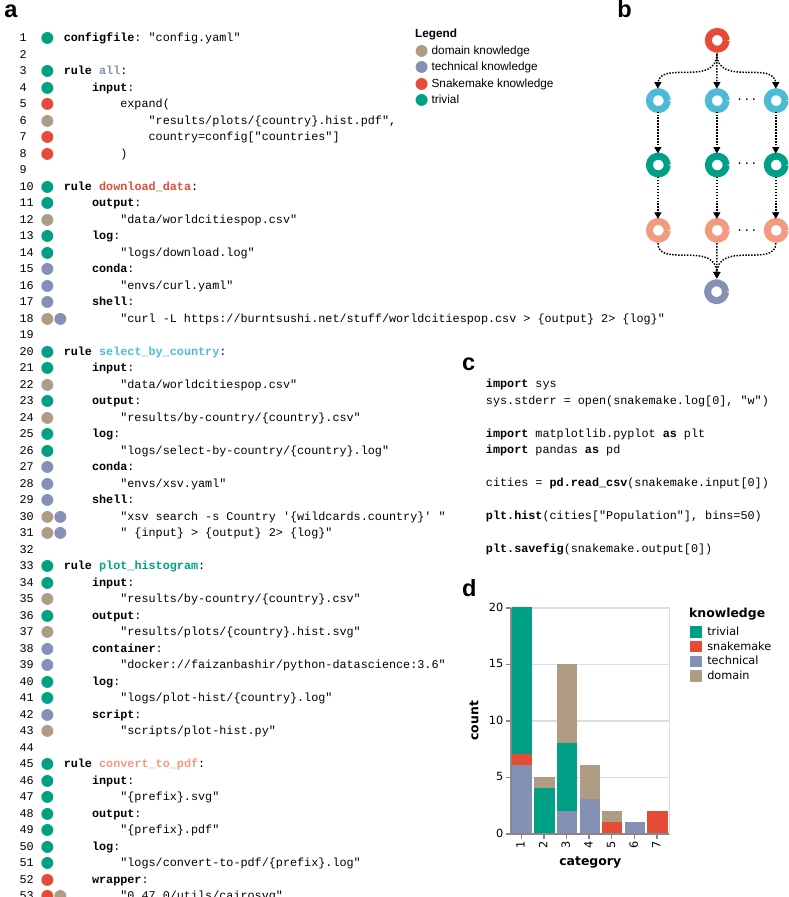
Figure 3. Example Snakemake workflow. ( a ) workflow definition; hypothesized knowledge requirement for line readability is color-coded on the left next to the line numbers. ( b ) directed acyclic graph (DAG) of jobs, representing the automatically derived execution plan from the example workflow; job node colors reflect rule colors in the workflow definition. ( c ) content of script plot-hist.py referred from rule plot_histogram. ( d ) knowledge requirements for readability by statement category (see subsection 3.3). The example workflow downloads data, plots histograms of city populations within a given list of countries, and converts these from SVG to PDF format. Note that this is solely meant as a short yet comprehensive demonstration of the Snakemake